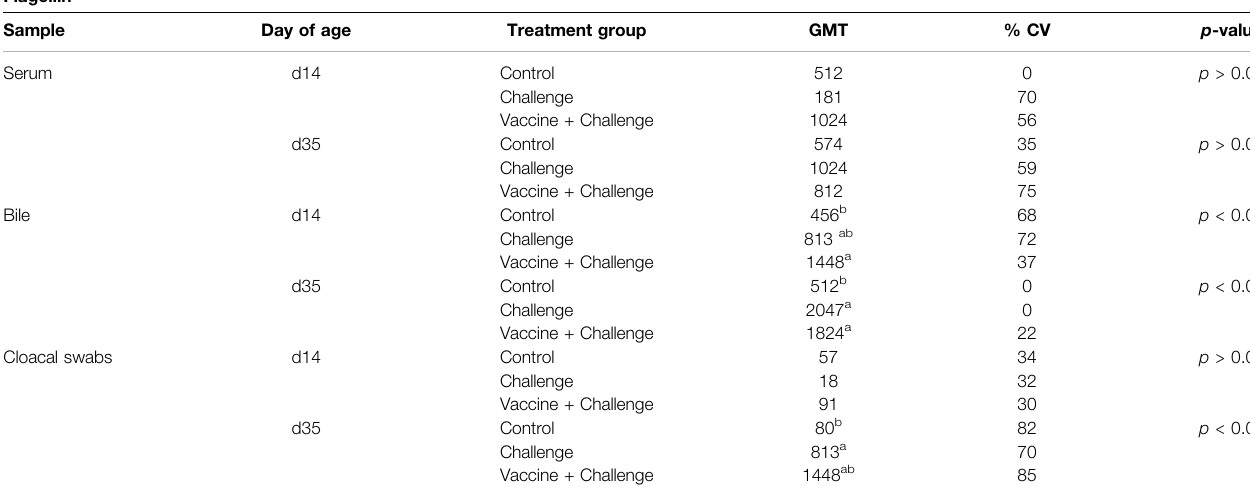
TABLE7| TheGMTofanti- S. EnteritidisFlagellinIgYandIgAantibodies.Blood,bile,andcloacalswabssampleswerecollectedatd14ofage(pre-challenge)andd35ofage (post-challenge).Sampleswereanalyzedforanti- Salmonella FlagellinIgYandFlagellinIgAlevelsbyELISA( n =6).Resultswerereportedasgeometricmeantiters(GMT). Values with no common superscript differ ( p < 0.05). The percent increase was determined as [(GMT of Vaccine + Challenge) – (GMT of Control)] ÷ (GMT of Control) × 100. Flagellin